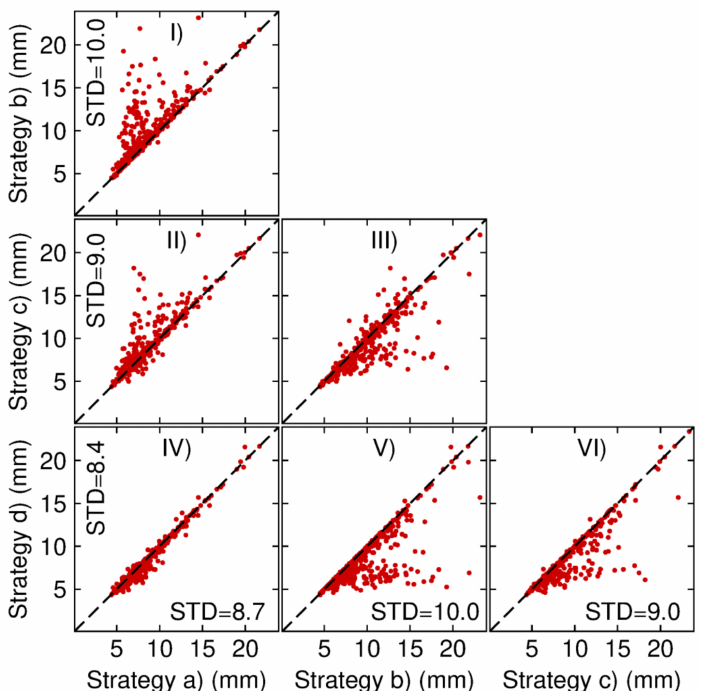
Figure 7. Ambiguity-fixed mean standard deviations of position errors comparison in the north direction between the daily kinematic PPP-AR solutions based on strategies (a), (b), (c) and (d). For I-VI panels, each panel denotes the comparison of two strategies.